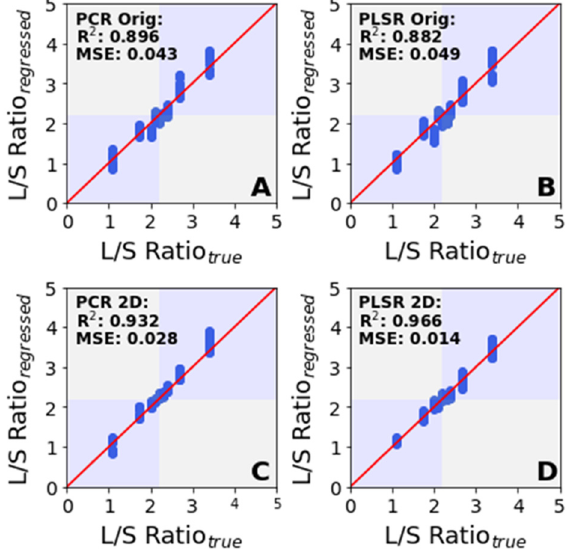
Figure 5. Performance of the regression models in predicting the L/S ratio. The maximum prediction interval range in ( A ) is +0.381, − 0.461; in ( B ) is +0.669, − 0.777; in ( C ) is +0.302, − 0.377; and in ( D ) is (cid:3397)0.291 , −0.371 .